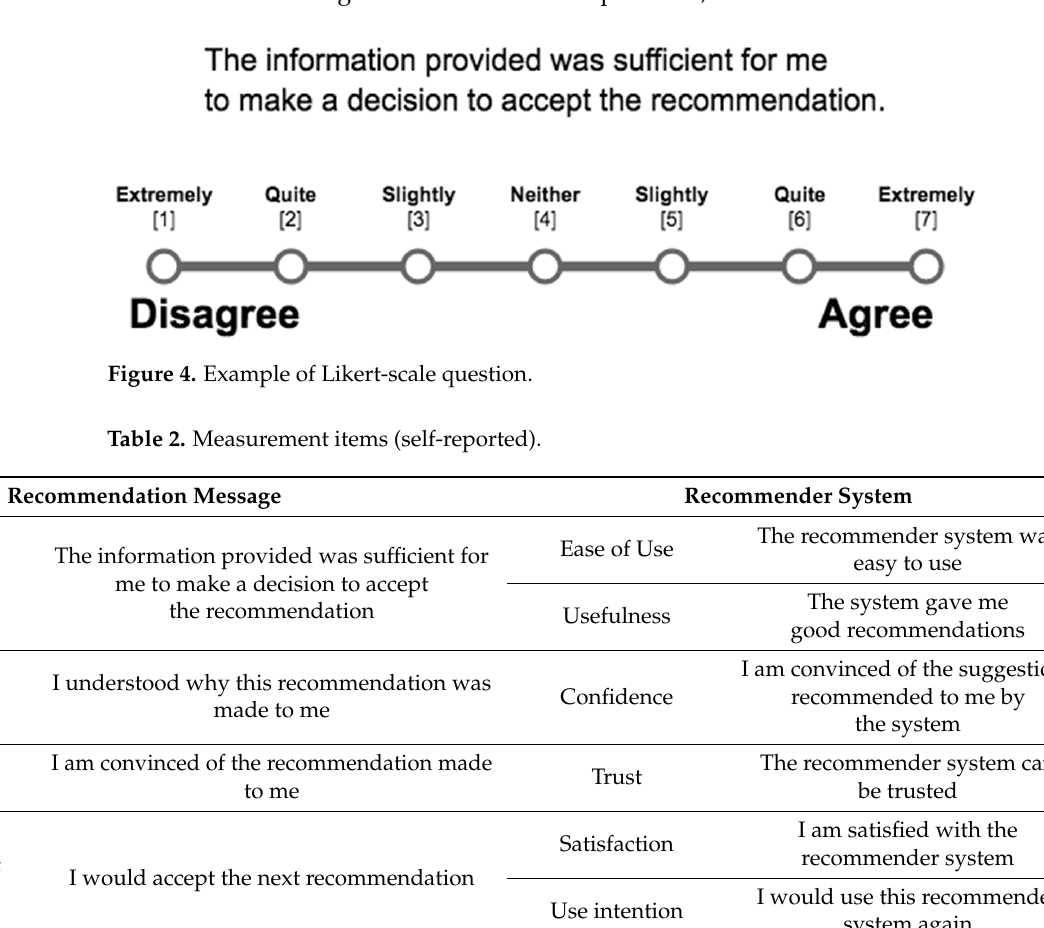
Figure 3. Example of study stimulus.